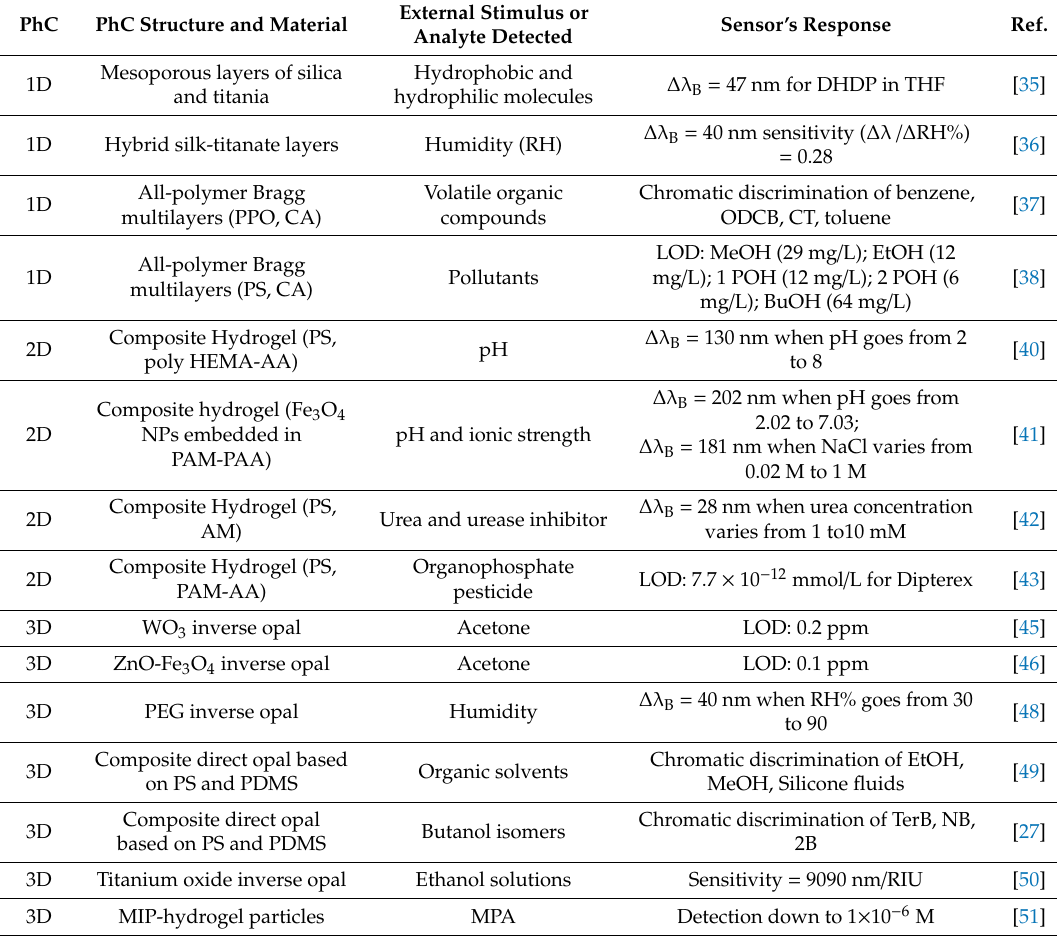
Table 1. Summary of the photonic crystal structures for chemical sensing presented in Section 3. The first column (left) indicates the dimensionality of the PhC, whereas the second column indicates the type of structure and its constituting materials. ∆ λ B is the value of the shift of the Bragg peak’s wavelength. When available, the value of the limit of detection (LOD) is